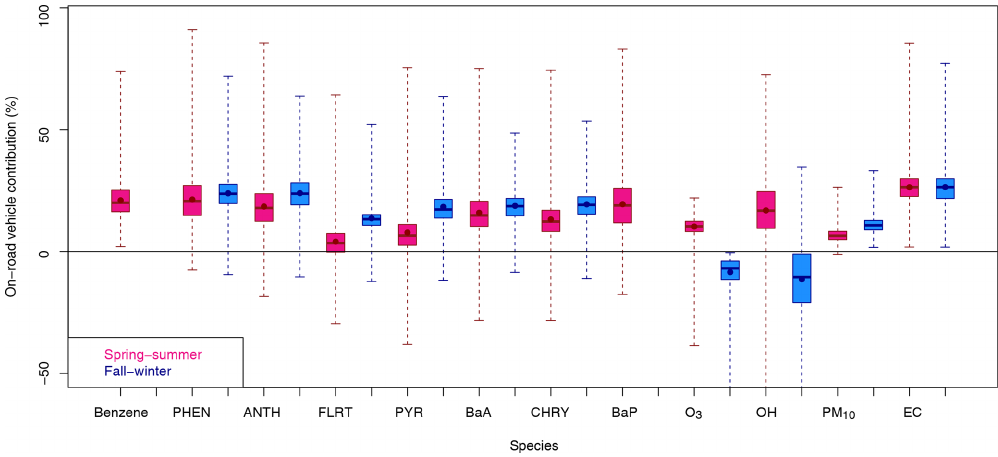
Figure 5. Seasonal-averaged relative on-road vehicle contributions to daily-average surface concentrations (in percent of total) in the model domain for all pollutants studied. Whiskers extend to the maximum range of the data in the domain, the centre line is the domain median, and the dots are the domain